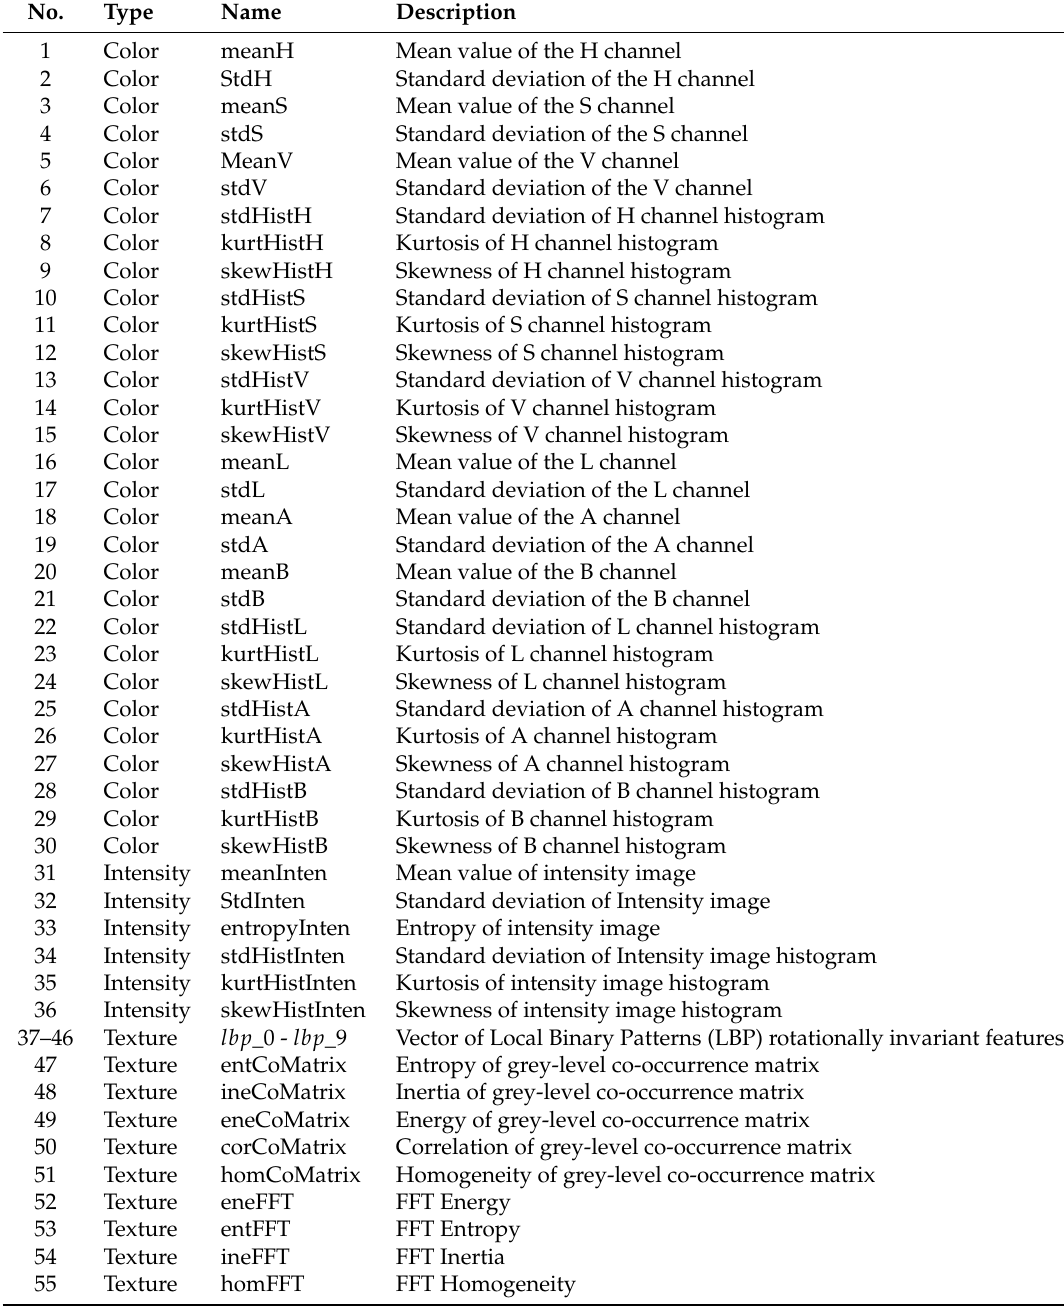
Table 2. List of all image features used in the proposed SPPe approach for barley flour classification.